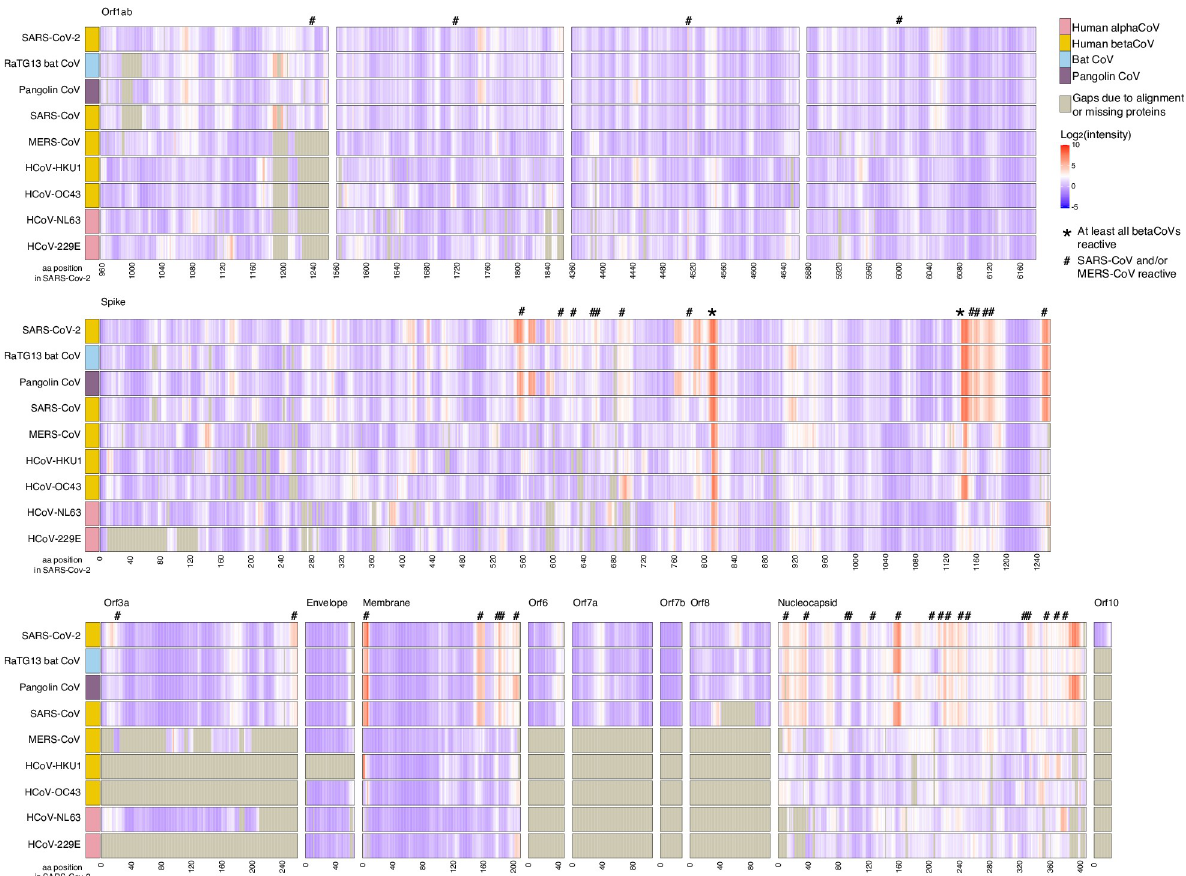
Fig 5. Anti-SARS-CoV-2 antibodies may cross-react with other CoVs. Sera from 40 COVID-19 convalescent patients were assayed for IgG binding to 9 CoVs on a peptide microarray; averages for all 40 are shown. Viral proteins are aligned to the SARS-CoV-2 proteome; SARS-CoV-2 aa position is represented on the x-axis. Regions that may be cross-reactive across all β -CoVs ( � ) or cross-reactive for SARS-CoV or MERS-CoV (#) are indicated. Gray shading indicates gaps due to alignment or lacking homologous proteins. Cross-reactive binding is defined as peptides in which patients’ average log 2 -normalized intensity is 2-fold greater than controls’ and t test statistics yield adjusted p -values < 0.1. The data used in this analysis can be accessed online at: https://github.com/Ong-Research/UW_Adult_Covid-19. aa, amino acid, β -CoV, betacoronavirus; CoV, coronavirus; COVID-19, coronavirus disease 2019; IgG, immunoglobulin G; MERS-CoV, Middle Eastern respiratory syndrome coronavirus; SARS-CoV, severe acute respiratory syndrome coronavirus; SARS-CoV-2, severe acute respiratory syndrome coronavirus 2.